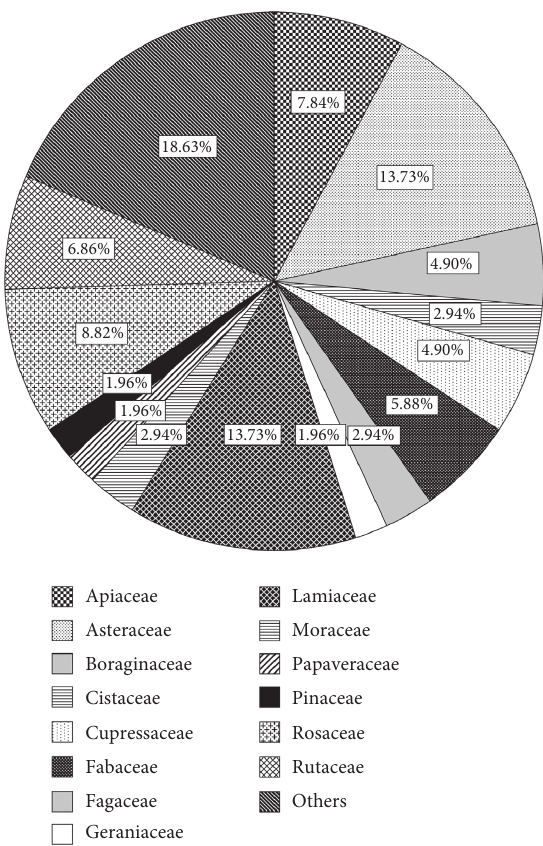
Figure 6: The most representative families of melliferous